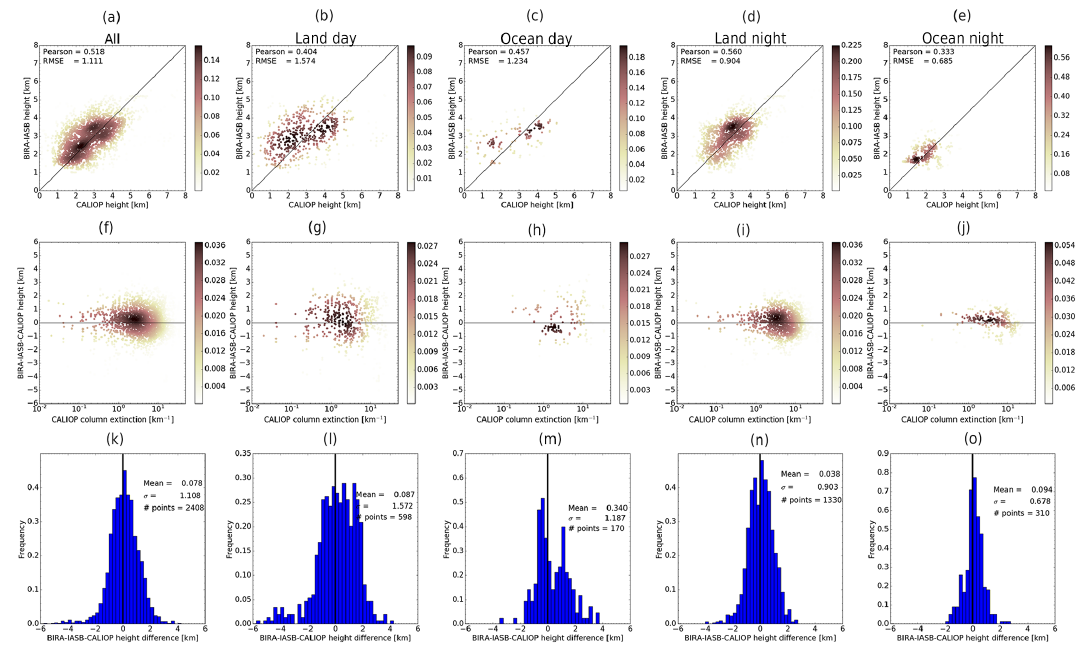
Figure A1. (a–e) Scatter plots of the CALIOP geometric mean height versus height from the BIRA-IASB algorithm. (f–j) Scatter plot of the difference between the BIRA-IASB and CALIOP heights versus the CALIOP column extinction. (k–o) Frequency distribution of the difference between the height from the BIRA-IASB algorithm and the CALIOP height. The mean and standard deviation of the normal distribution are given in each plot. (a, f, k) All data points. (b, g, l) CALIOP daytime data and IASI land pixels. (c, h, m) CALIOP daytime